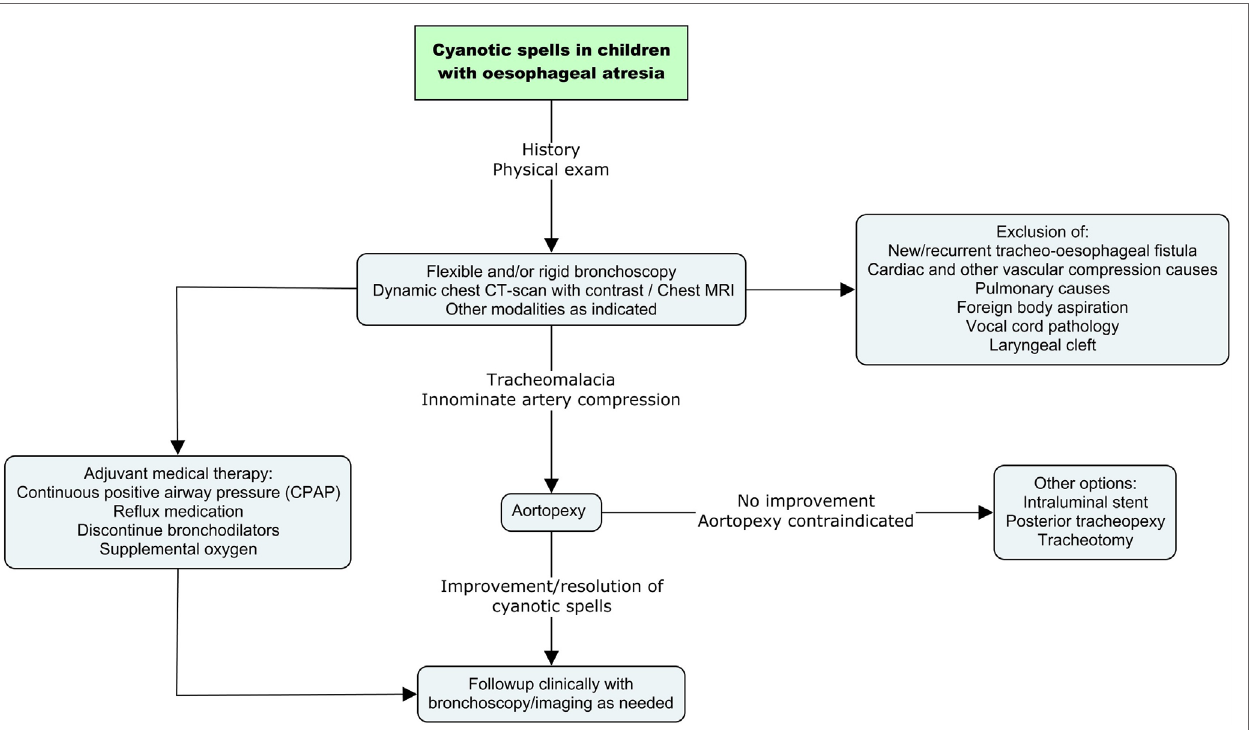
FiGURe 1 | The management of cyanotic spells in children with oesophageal atresia